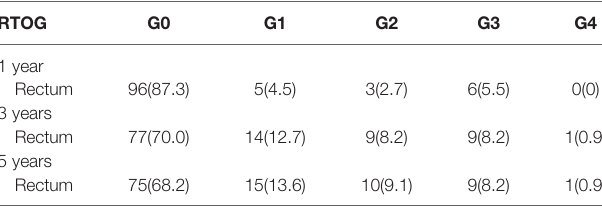
TABLE 2 | The incidence of late rectum and bladder morbidity in patients with locally advanced cervical cancer at 1/3/5 years according to RTOG